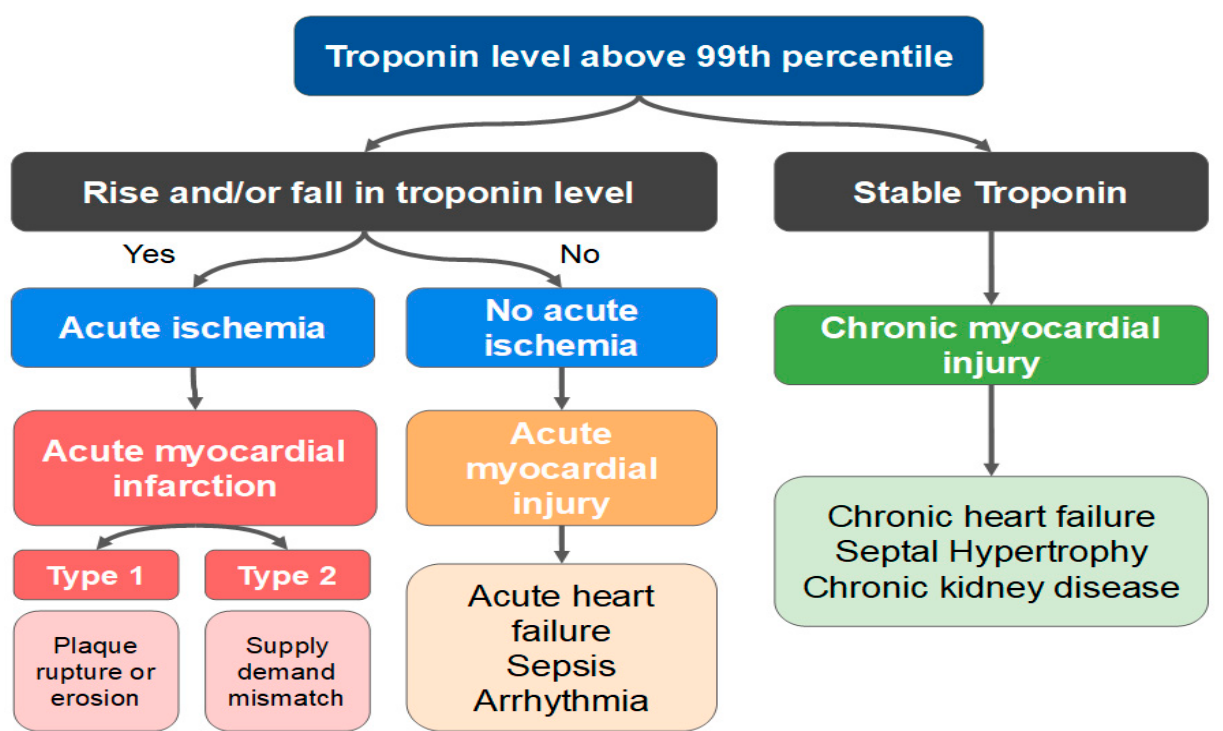
Figure 9. Differences between acute myocardial infarction (AMI) and acute/chronic myocardial